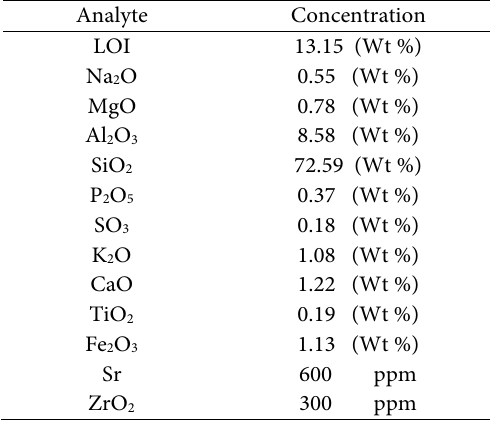
Table 1. XRF pattern of natural zeolite